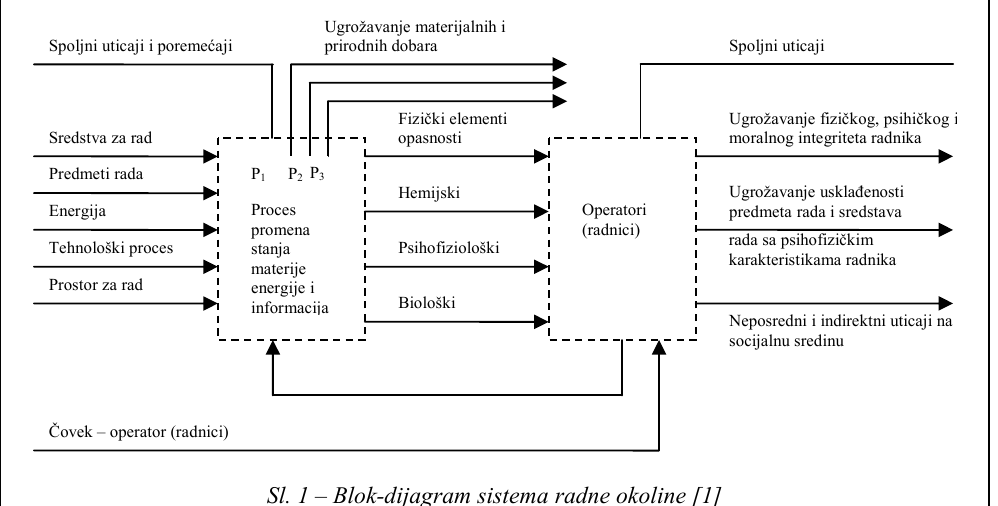
U tabeli 1 dat je pregled izlaznih